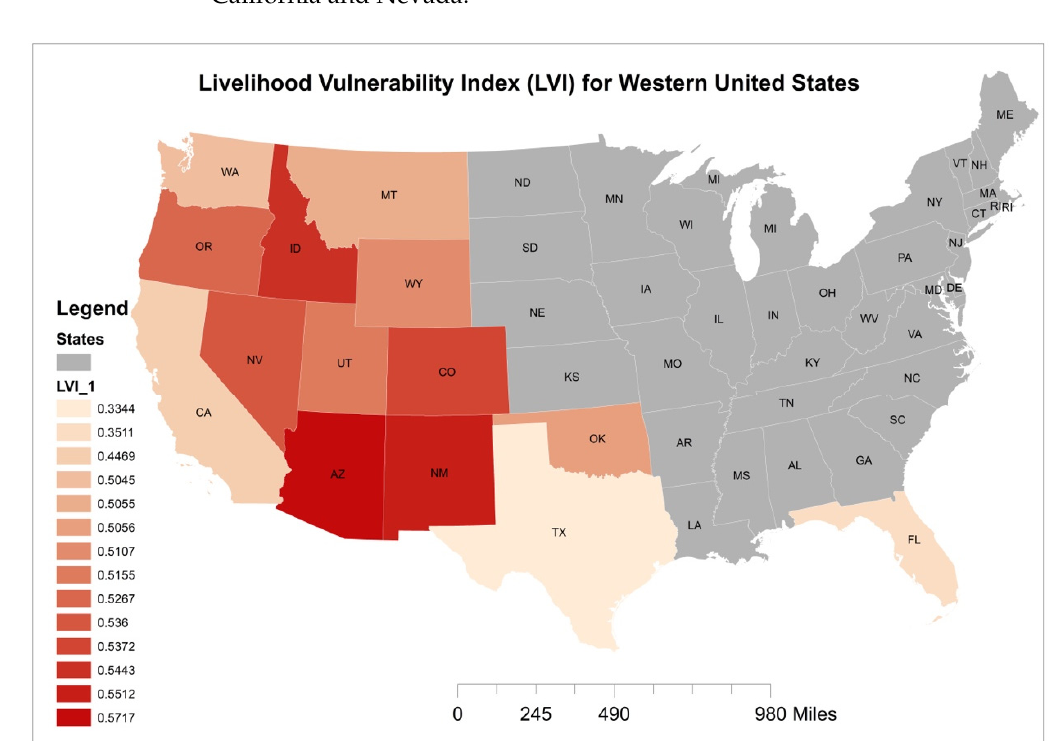
Figure 3. Map of each states’ LVI value, with its magnitude corresponding to the color bar where darker red indicates the highest LVI. States shaded gray have not been analyzed in this study.